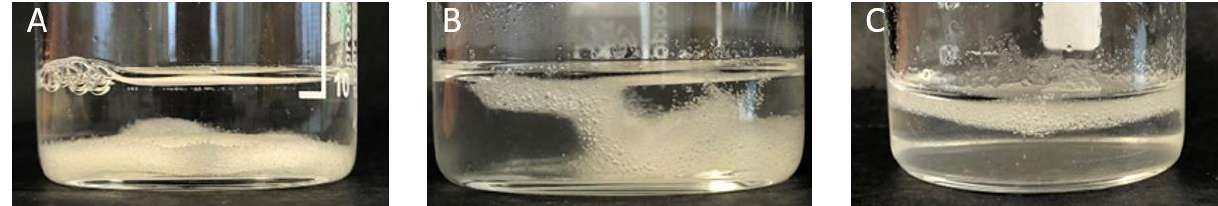
Figure 3. Stages of matrices disintegration (disintegration test of Pul40/Alg formulation in time: ( A ) matrices after 30 min, ( B ) matrices after 180 min, ( C ) matrices after 300 min of the dissolution process (picture taken with Nikon S9300 camera using macro lens).